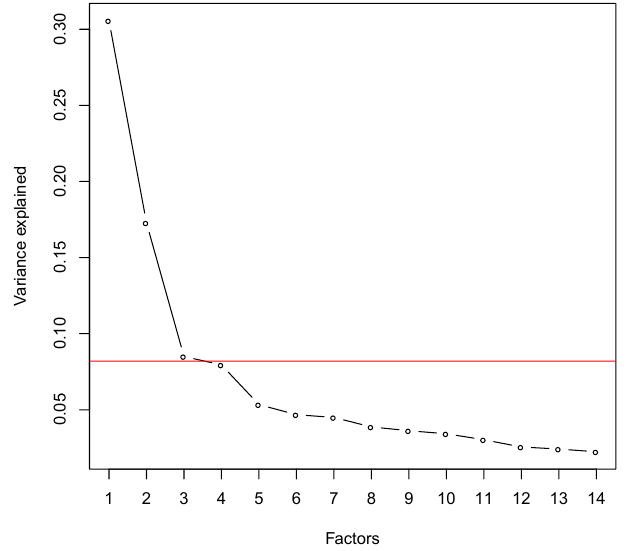
Figure 3. Variance explained by each factor for WhatsApp Indian